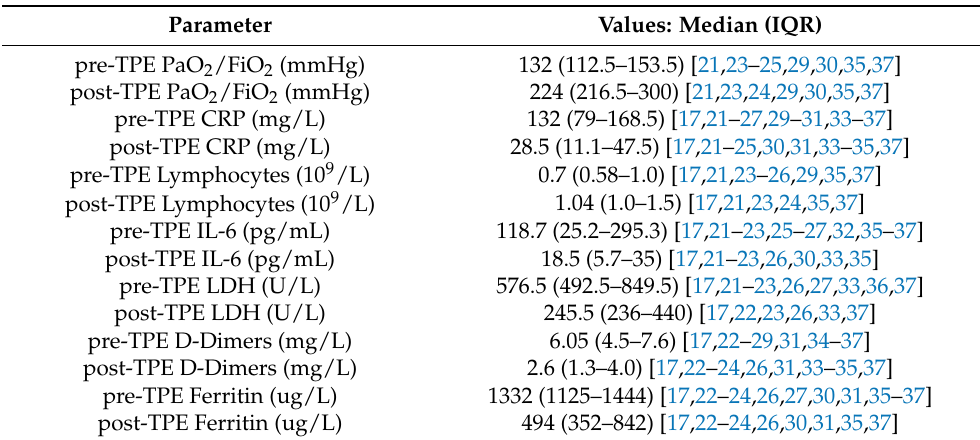
Table 3. Median and interquartile ranges of values of various biomarkers measured before and after